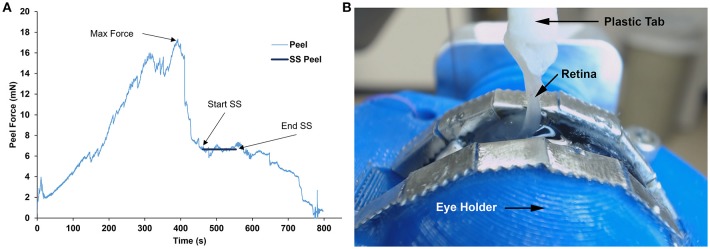
(A) Representative peel test showing peel force over time for a sheep specimen. Steady-state (SS) peel region started after maximum peel force was reached and ended before the retina began to fail. Steady-state peel force was calculated by averaging forces during the steady-state peel period. (B) Still image taken from the webcam video of a sheep retina peeling away from the vitreous at 90° during the steady-state peel region.